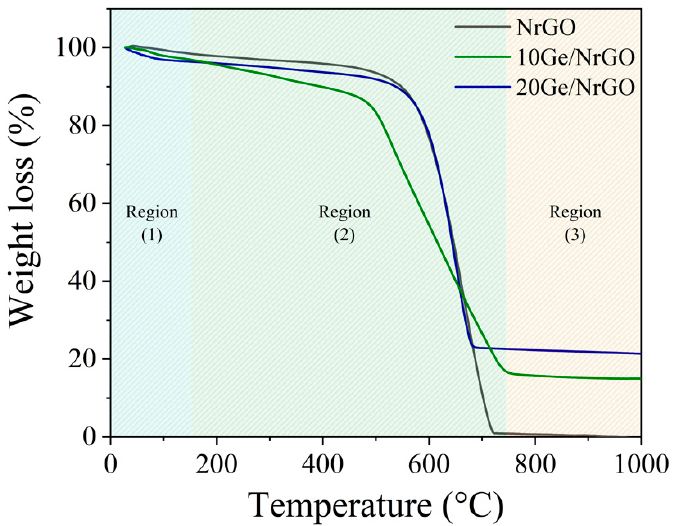
Figure 8. The prepared products were heated to temperatures ranging between RT-1000 ◦ C